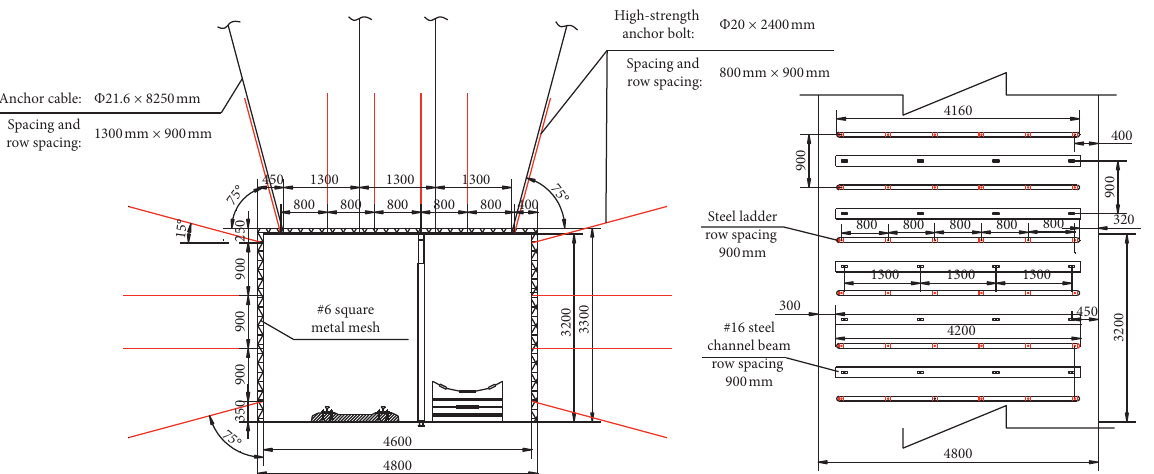
Figure 15: Cross section of the roadway and support design of intake airway of working face 11030.